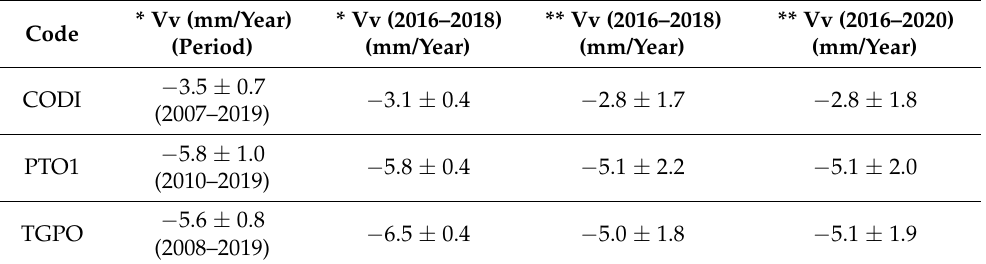
Table 1. Vertical velocities of the 3 CGNSS stations estimated by [53] and during the present work (see text for more